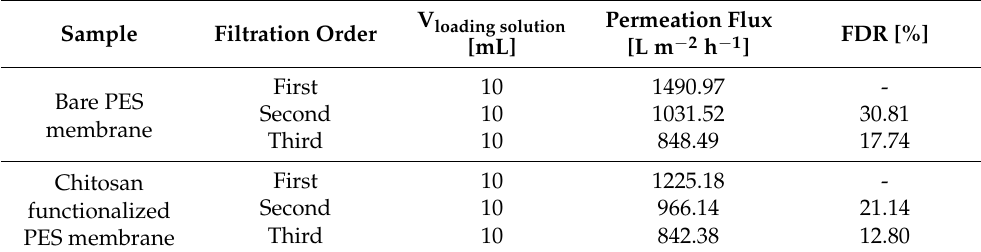
Table 4. Fouling behavior of PES membrane